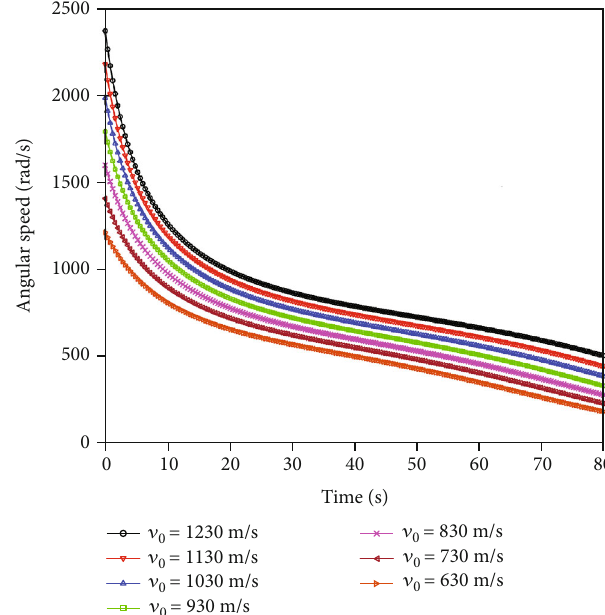
Figure 3: Velocity at di ff erent initial